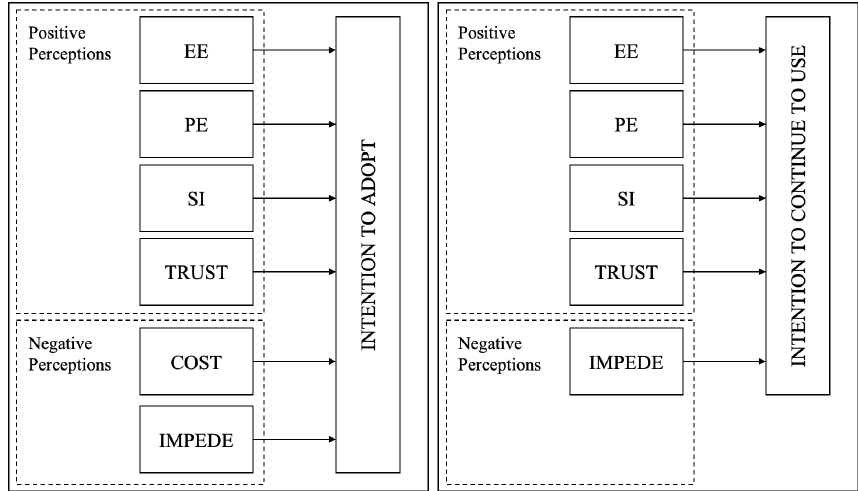
Figure 1. Proposed research models for non-Users and